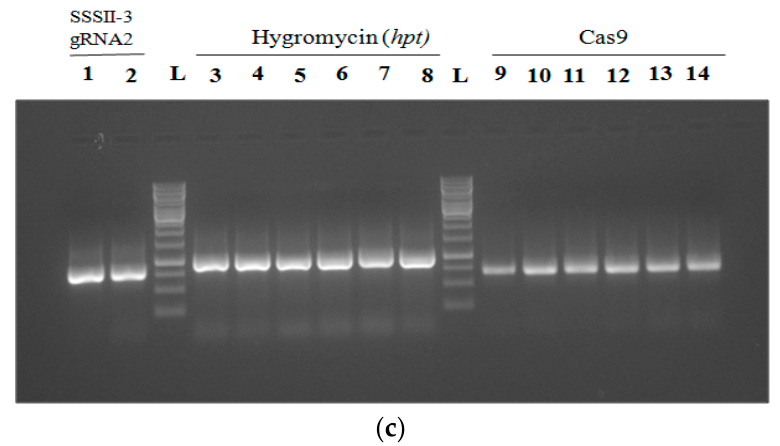
Figure 2. The formation of construction of three isoforms of soluble starch synthases: SSSII-1, 2, and 3 . The L band is 1 kb DNA ladder. ( a ) The confirmation with PCR of bands 1 to 6 for SSSII-1 target 1 primer, bands 7 to 12 of SSSII-2 target 2, PCR confirmation of SSSII-1 with Cas9 bands 13 to 18, and hygromycin ( hpt ) bands 19 to 24; ( b ) bands 1 to 6 of SSSII-2 target 1, bands 7 to 12 of SSSII-2 target 2, bands 13 to 18 used for hygromycin marker, the PCR confirmation of SSSII-2 gene with Cas9 bands 19 to 24, bands 25 to 30 for SSSII-3 target 1, and bands 31 to 34 for SSSII-3 target 2; ( c ) bands 1 and 2 for SSSII-3 target 2, hygromycin ( hpt ) PCR confirmation of SSSII-3 bands 3 to 8, and bands 9 to 14 for Cas9.